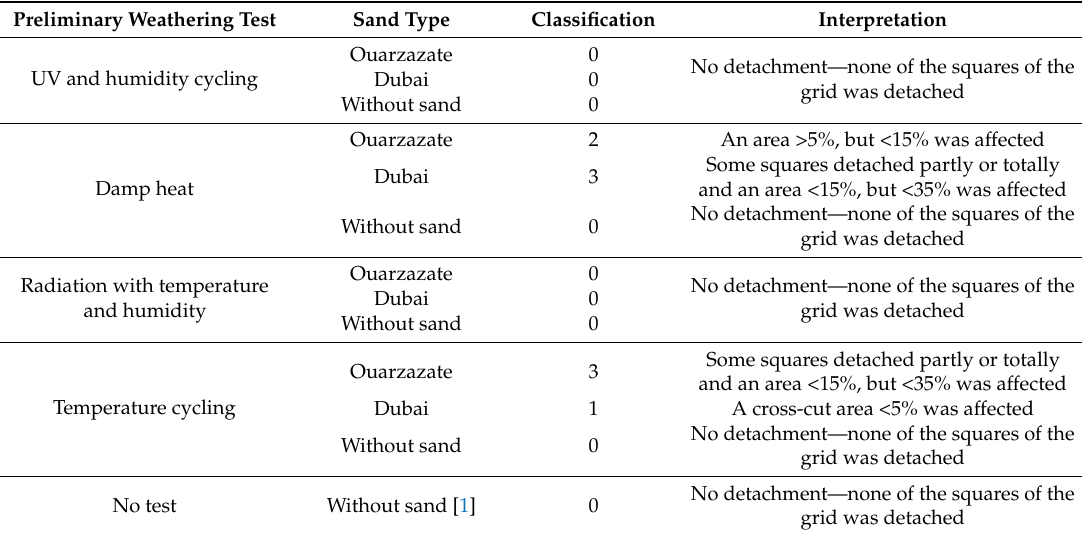
Table 4. Results of the cross-cut experiment applied to the second set of samples after the preliminary weathering tests, according to ISO 2409.